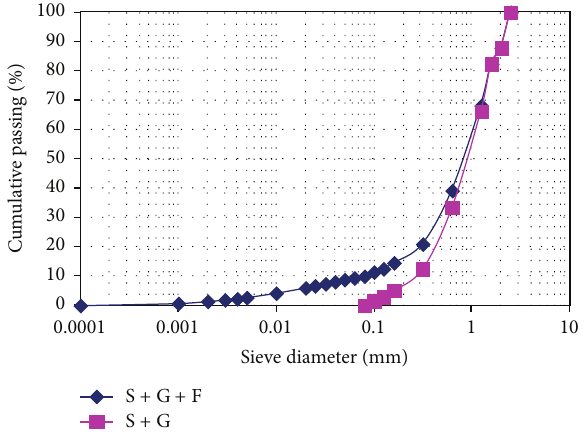
Figure 4: Effect of introducing calcareous fillers on the grading distribution of the solid